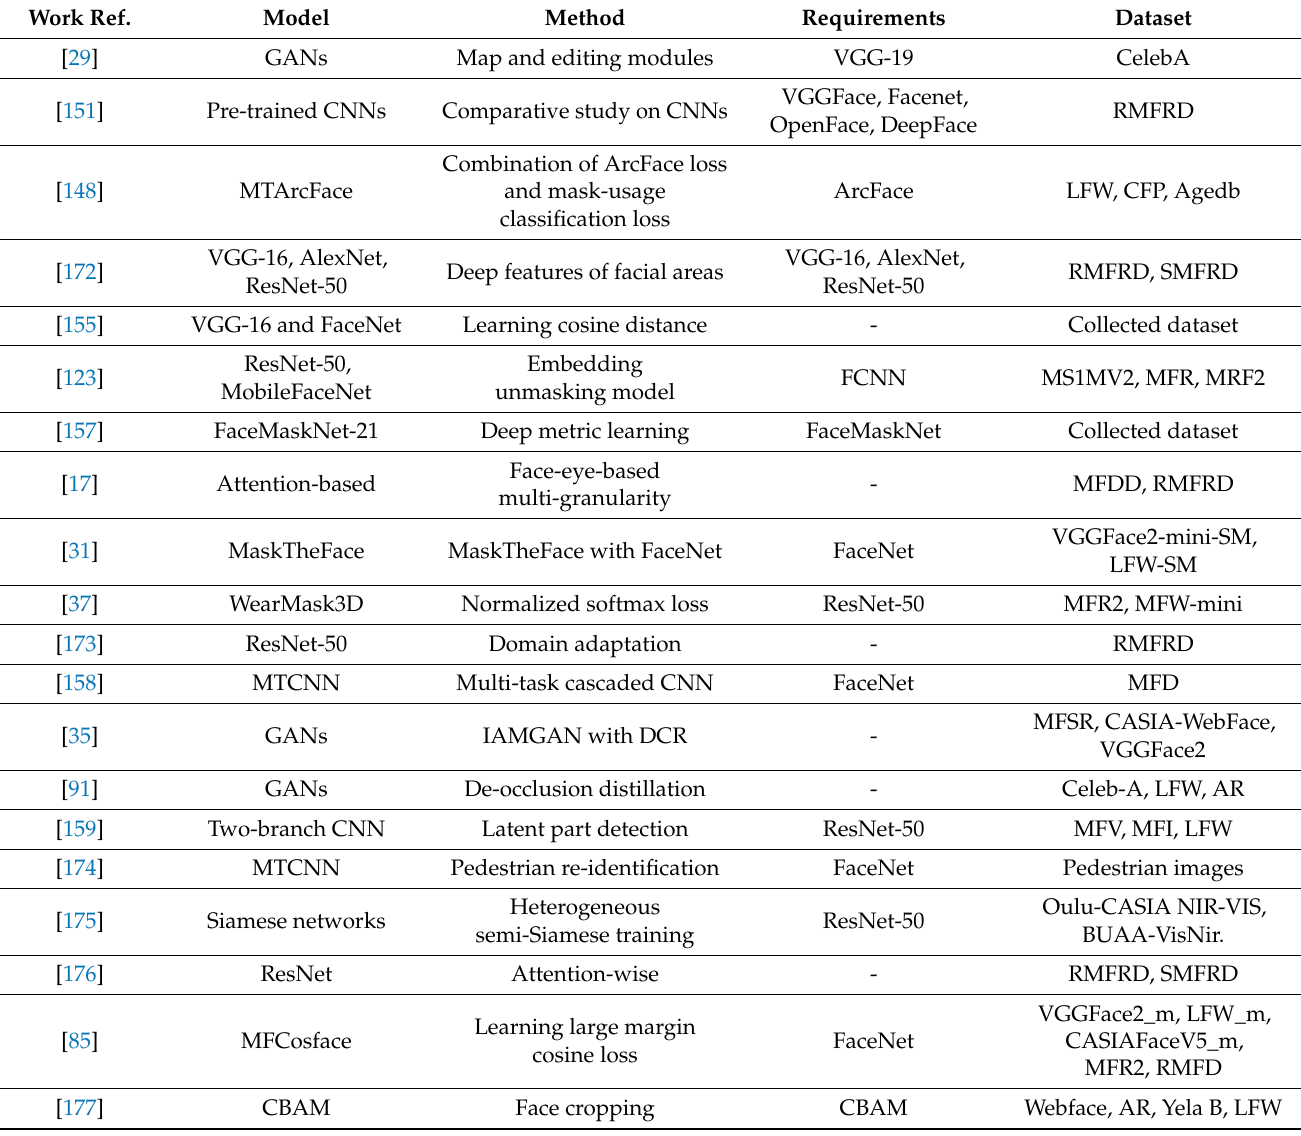
Table 4. A summary of MFR approaches.